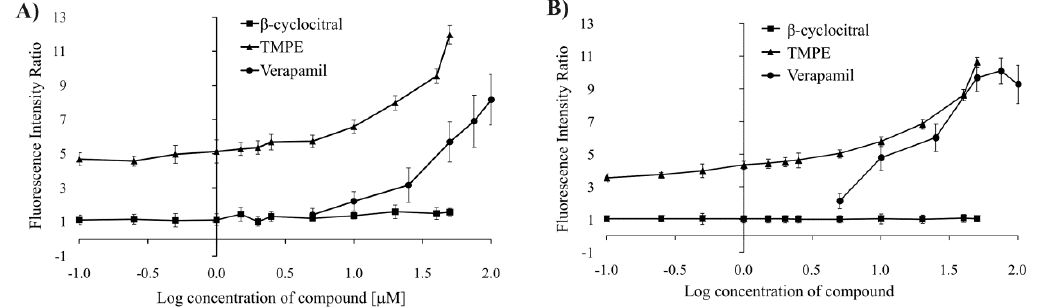
Figure 5. The influence of β-cyclocitral and TMPE on the intracellular accumulation of rhodamine 123 (Rho123) in LoVo/Dx ( A ) and HT29/Dx cells ( B ). Mean ± S.D. of three experiments are presented. The following FIR values were found to be statistically significant ( p < 0.05) as compared to the control: TMPE in all concentrations in LoVo/Dx cells; TMPE in all concentrations in HT-29/Dx cells; β-cyclocitral at the highest concentration in LoVo/Dx cells; verapamil in all concentrations (apart from the lowest) in LoVo/Dx cells; verapamil in all concentrations in HT-29/Dx cells.